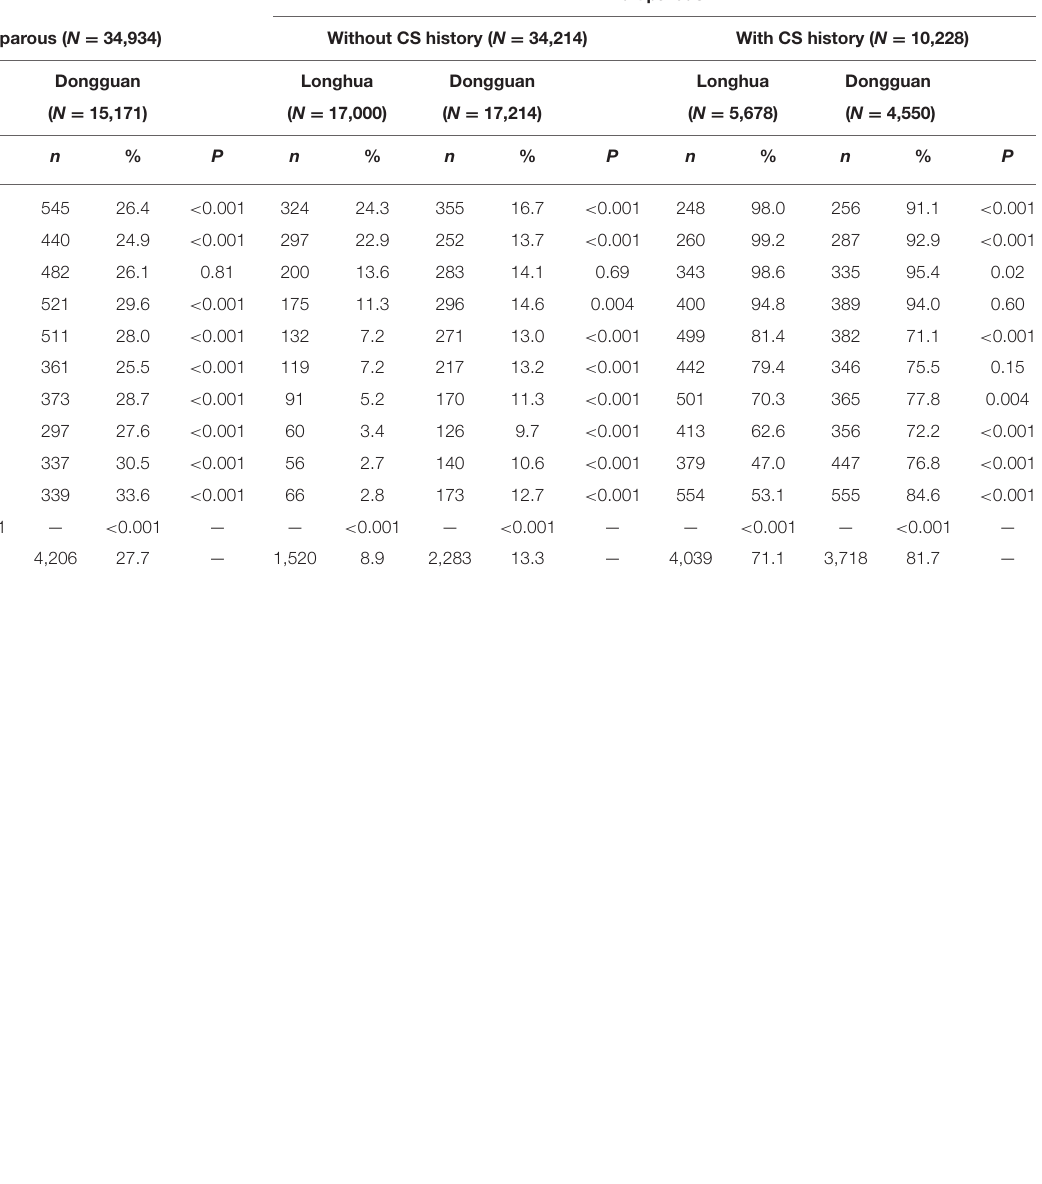
TABLE 3 | CS rates (%) in each year in all women and by parity and history of CS in two study hospitals.